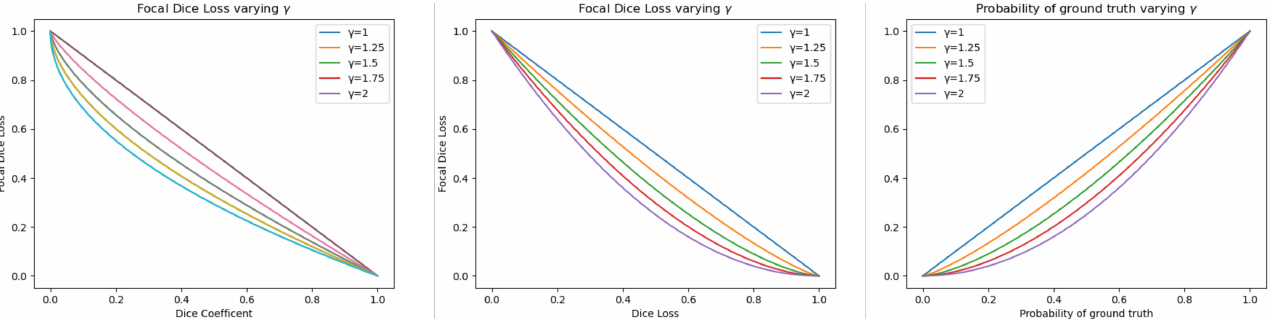
Figure 3. Left: values of FDL W as a function of the Dice coefficient varying γ . Center: values of FDL A as a function of the Dice loss. Right: values of p i varying γ in the FDL B